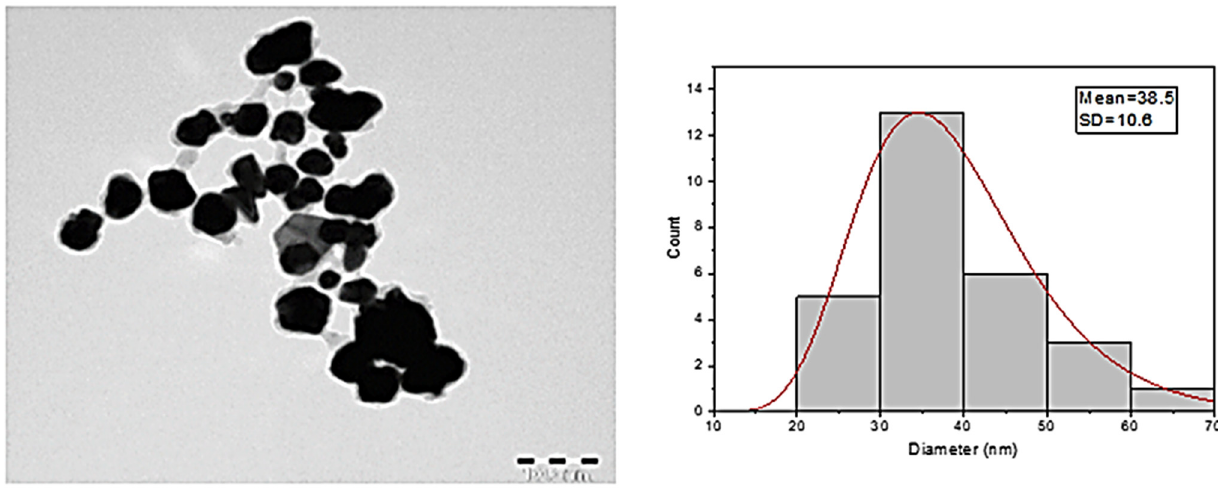
Figure 5. TEM images and diameter distribution of the AuNPs.